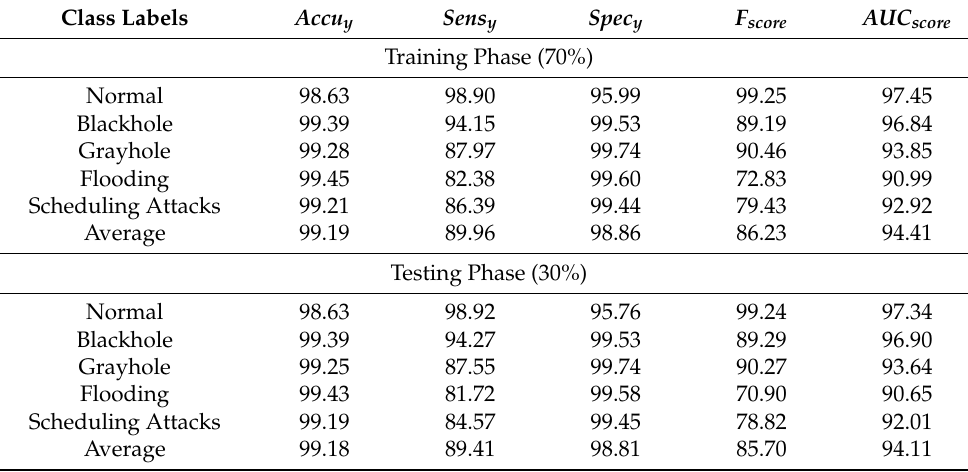
Table 3. Classifier outcome of the BCOA-MLID approach on TRP/TSP of 70:30. Class